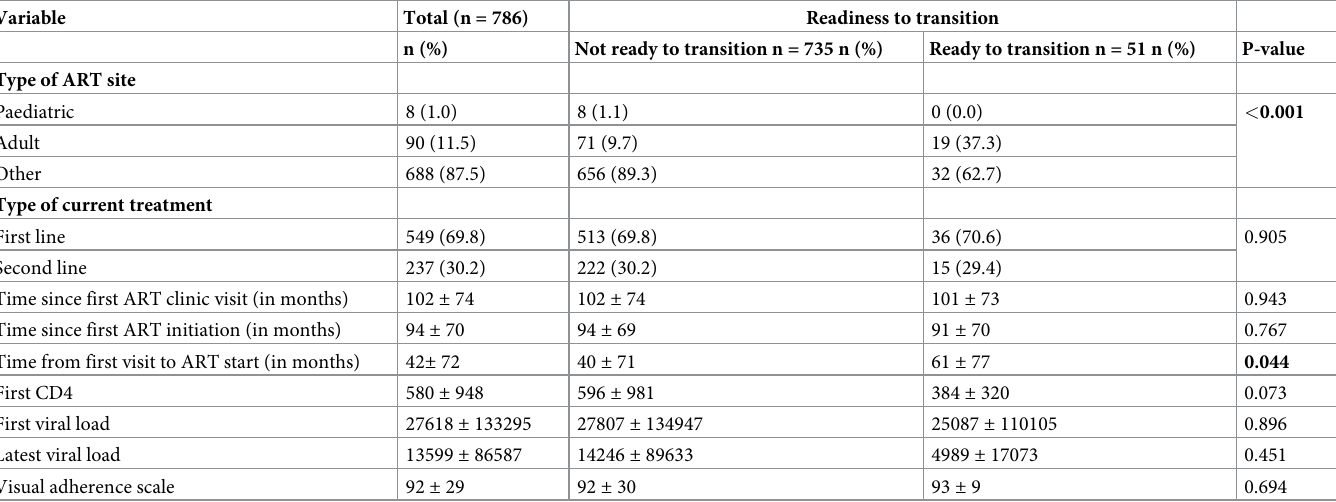
Table 2. Clinical and immunological characteristics of adolescents living with HIV and transition readiness.